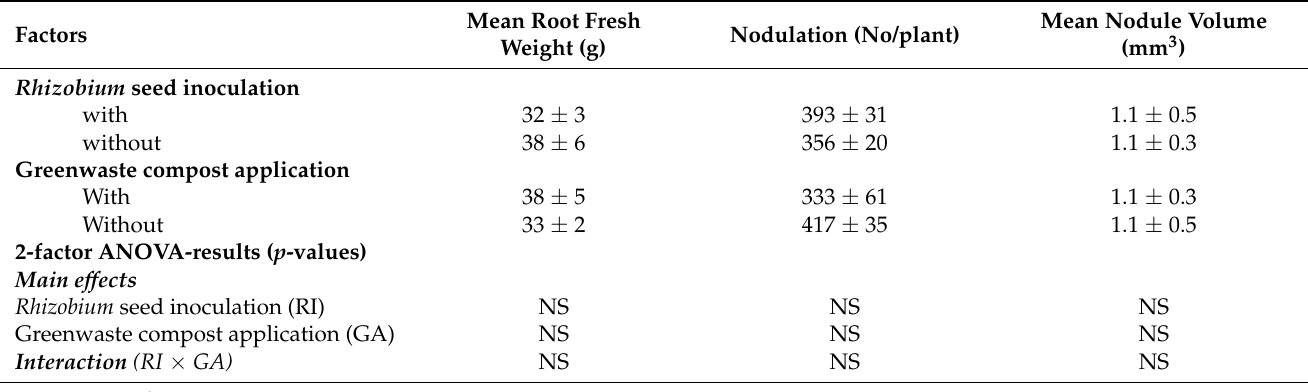
Table 5. Effect of Rhizobium inoculation of clover seed and greenwaste compost applications to clover swards on the mean root weight of clover plants, nodule number/plant and mean nodule volume in growing season 2 (2004). Values shown are main effect means ±